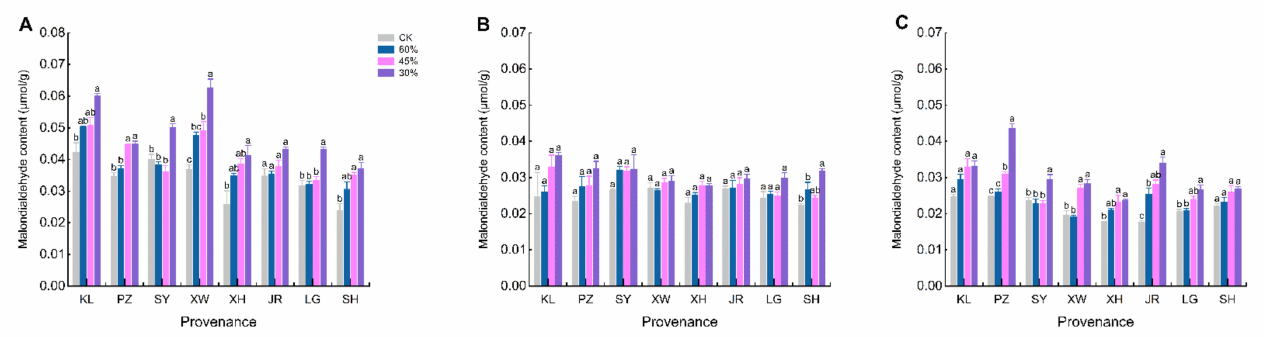
Figure A4. The malondialdehyde content of Melia azedarach among the different provenances: ( A ): early stage, ( B ): middle stage, and ( C ): late stage. Note: The error line in the figure is the mean ± standard error, and different lowercase letters in the same treatment indicate significant differences at the 0.05 level.